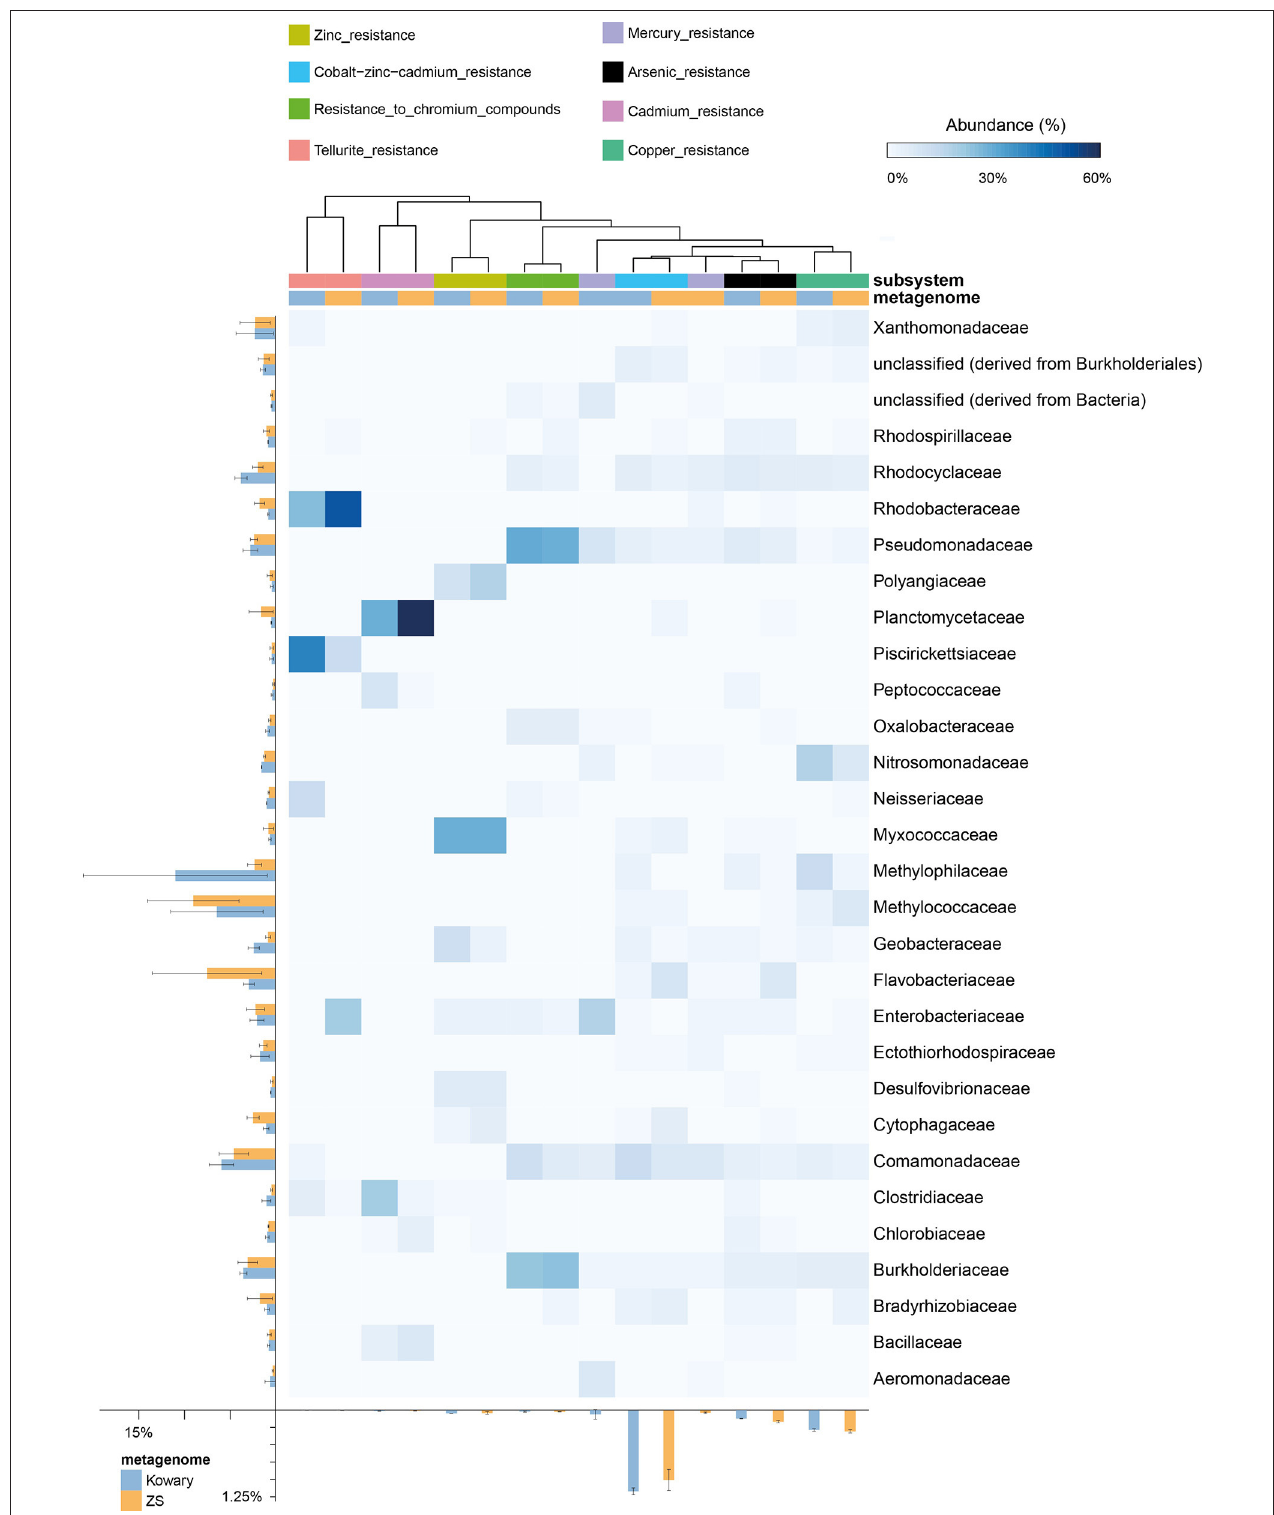
FIGURE 6 | Taxonomic distribution of reads assigned to heavy metal resistance subsystems. The heatmap shows relative abundance of reads classified to a given family in a particular subsystem. Total abundances in metagenomes are shown for families and subsystems on the left and at the bottom, respectively. Subsystems were clustered using the average neighbor (UPGMA) method. Mercury resistance indicates summarized data for mercuric reductase and mercury resistance operon subsystems.